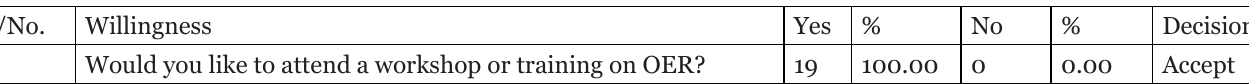
Participants’ Readiness to Attend a Workshop or Training on OERs S/No. Would you like to attend a workshop or training on